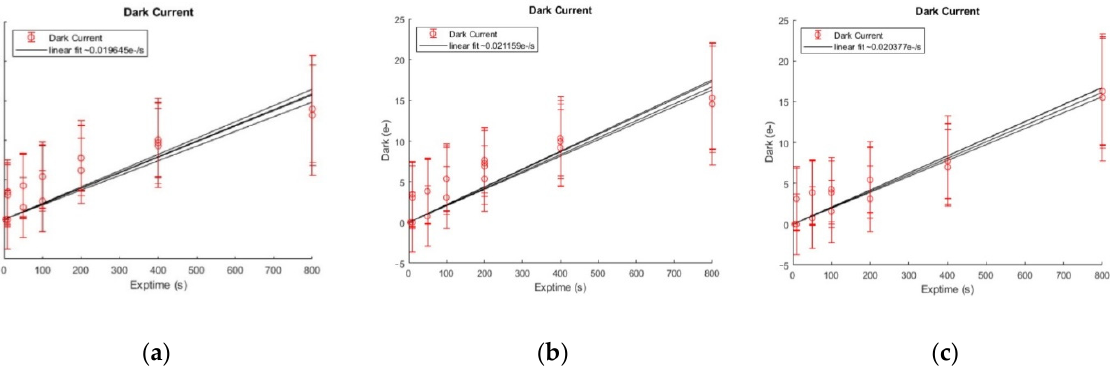
Figure 19. The dark current test result of the camera. ( a ) 28 June 2022 test result; ( b ) 6 July 2022 test result; ( c ) 19 July 2022 test result.